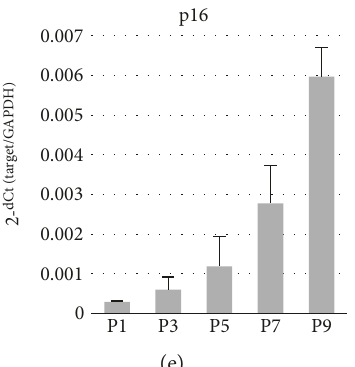
Figure 1: Transition to iNCMSCs from iNCCs and their expandability. (a) Schematic protocol for generation of iNCMSCs from iNCCs. (b) Cell morphology of iNCCs and iNCMSCs during expansion culture. Passage number and expanded days are presented in their inboxes. (c) Growth curve of iNCMSCs over two months ( N =three lines). Each symbol represents each passage. PDT was calculated during fi rst seven weeks (mean ± SD for three lines). (d) Senescence-associated β -galactosidase staining of iNCMSCs at passages 3 and 8. (e) Upregulation of p16 mRNA expression during expansion culture (means ± SD for three lines). Scale bars =100 μ m (b, d). Abbreviations: CDM: chemical de fi ned medium; SB: SB431452; PDL: population doubling level; PDT: population doubling time; iNCCs: induced neural crest cells; iPSCs: induced pluripotent stem cells; iNCMSCs: iNCC-derived mesenchymal stem